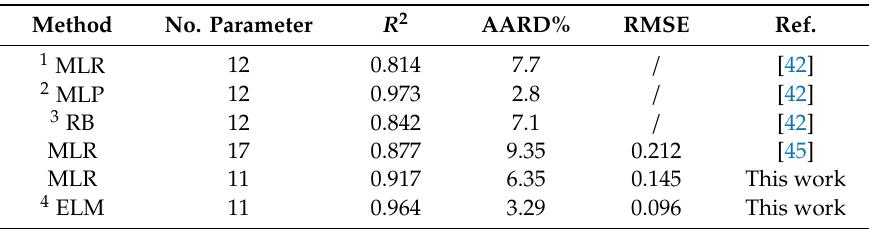
Table 4. Comparisons of our work with the reported